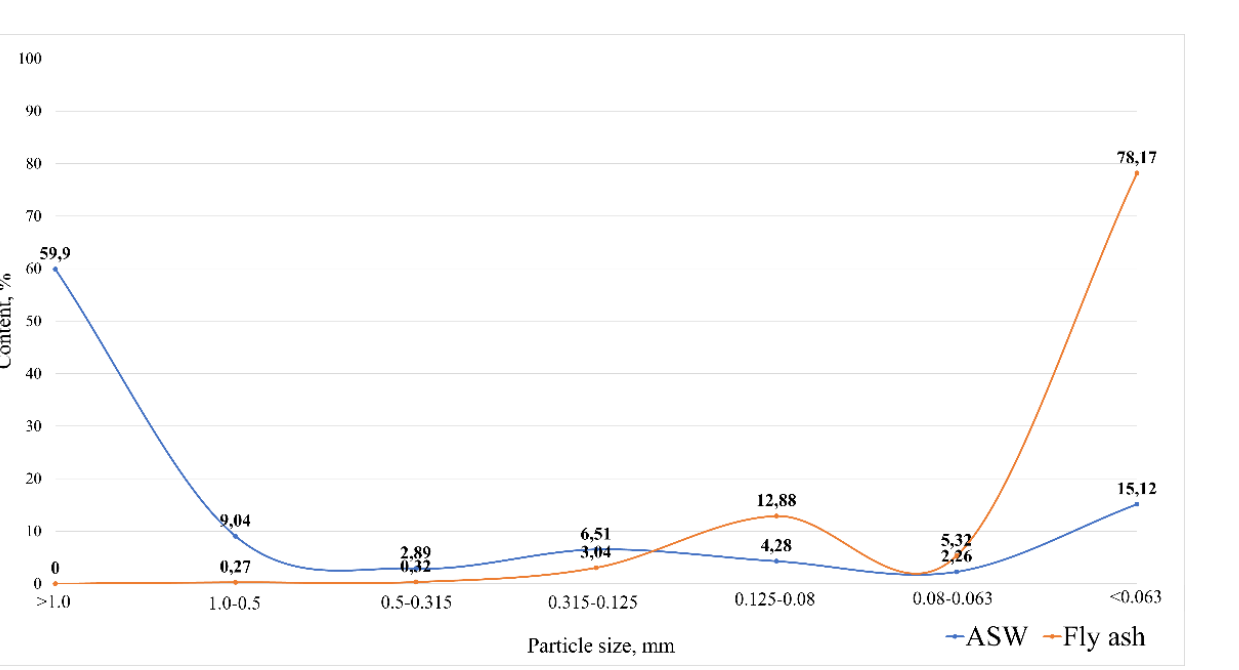
Figure 2. Particle size distribution diagrams.